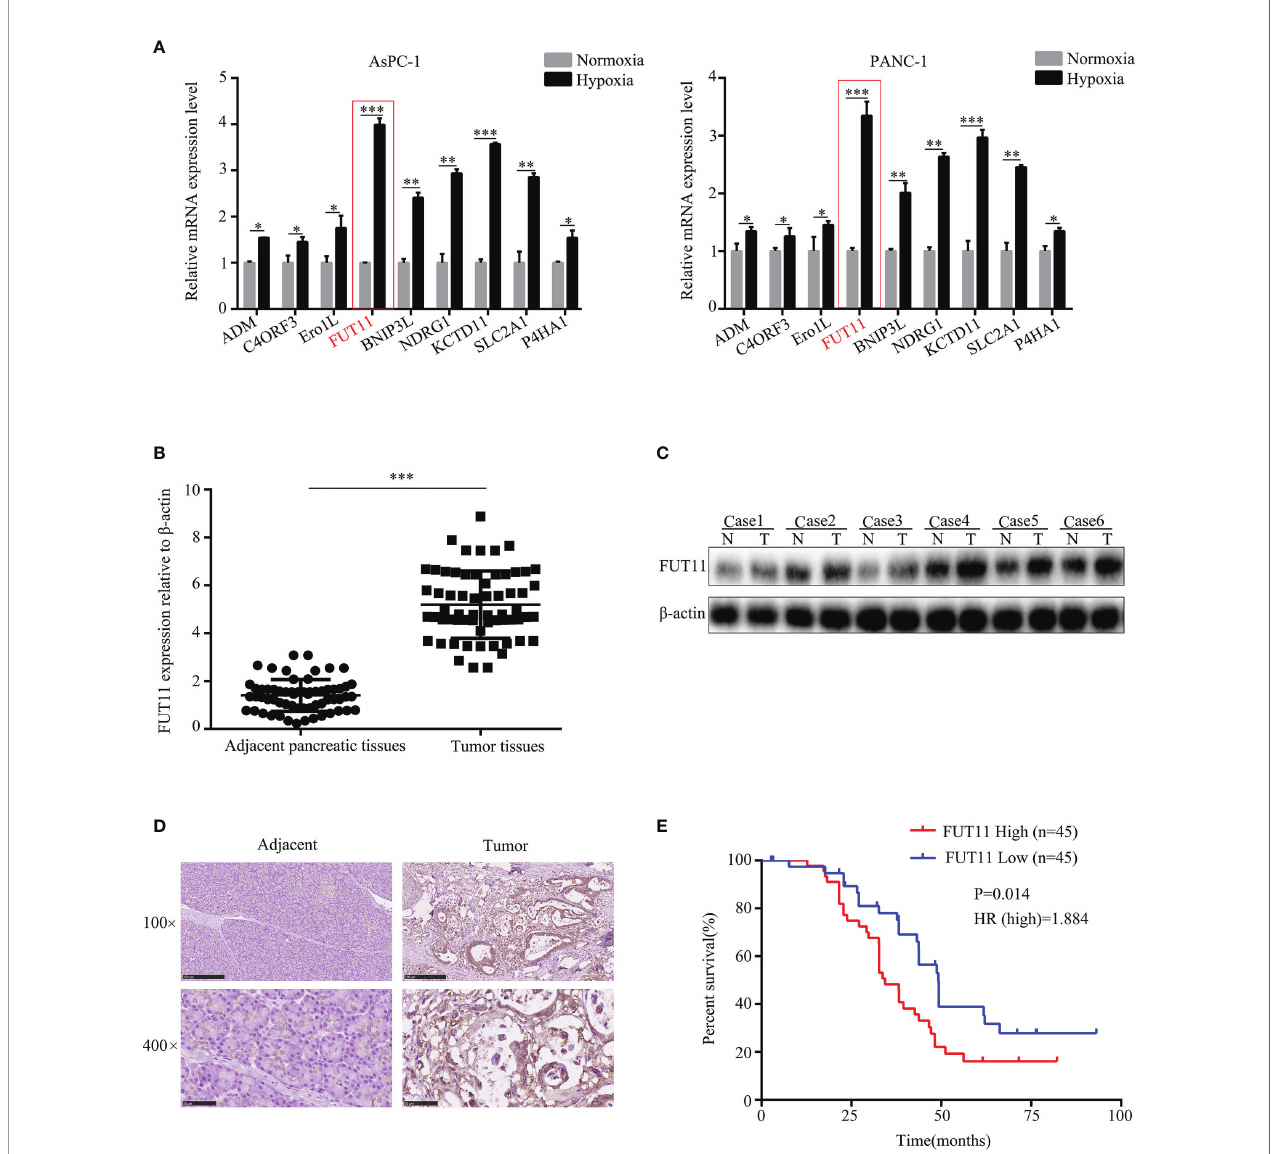
FIGURE 2 | FUT11 was up-regulated in PC and predicted poor outcome. (A) qRT-PCR analysis on the mRNA expression of ADM, C4ORF3, ERO1L, FUT11 BNIP3L, KDM3A, MXI1, NDRG1 and KCTD11 in AsPC-1 and PANC-1 cells under normoxia and hypoxia. (B) qRT-PCR analysis of mRNA level of FUT11 in 62 pairs of matched PC tissue and adjacent normal tissues. (C) Western blot analysis of protein level of FUT11 in PC tissue and adjacent normal tissues. (D) IHC analysis of the protein level of FUT11 in pancreatic cancer and normal pancreatic tissue. (E) 90 patients with PC were divided into high- and low-expression groups based on the expression of FUT11. Kaplan survival curve showed the overall survival of high FUT11(red) and low FUT11(blue) expression group. * P < 0.05; ** P < 0.01; *** P <